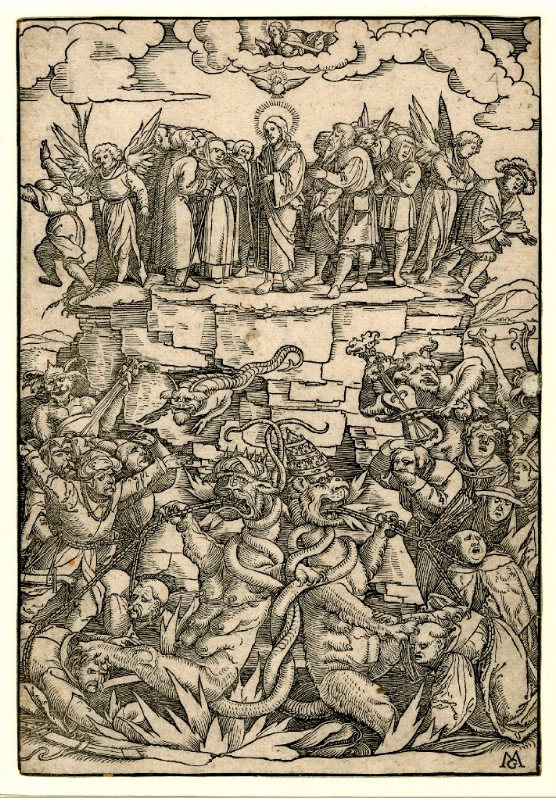
Figure 1. “Apocalypse” (Matthias 1546).